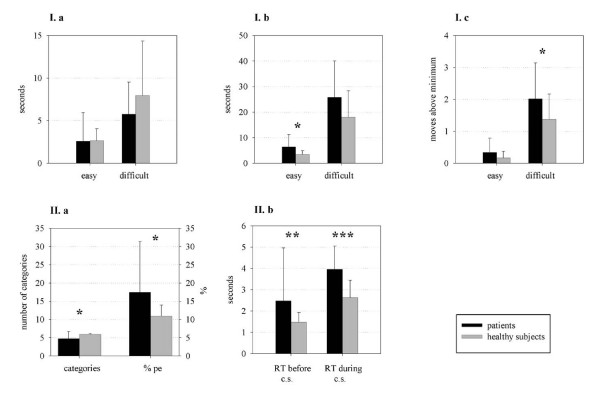
Performance during the SOC and WCST in patients (n = 22) and healthy subjects (n = 20) SOC: I a. Adjusted planning time during easy and difficult problems, I b. Movement execution time, I c. Average moves above minimum, WCST: II a. Number of categories and percentage of perseverative errors (%pe), II b. Reaction time (RT) during maintaining set and set shifting. Abbreviation: c.s.: category shift. *P < 0.05, **P < 0.01, ***P < 0.001.